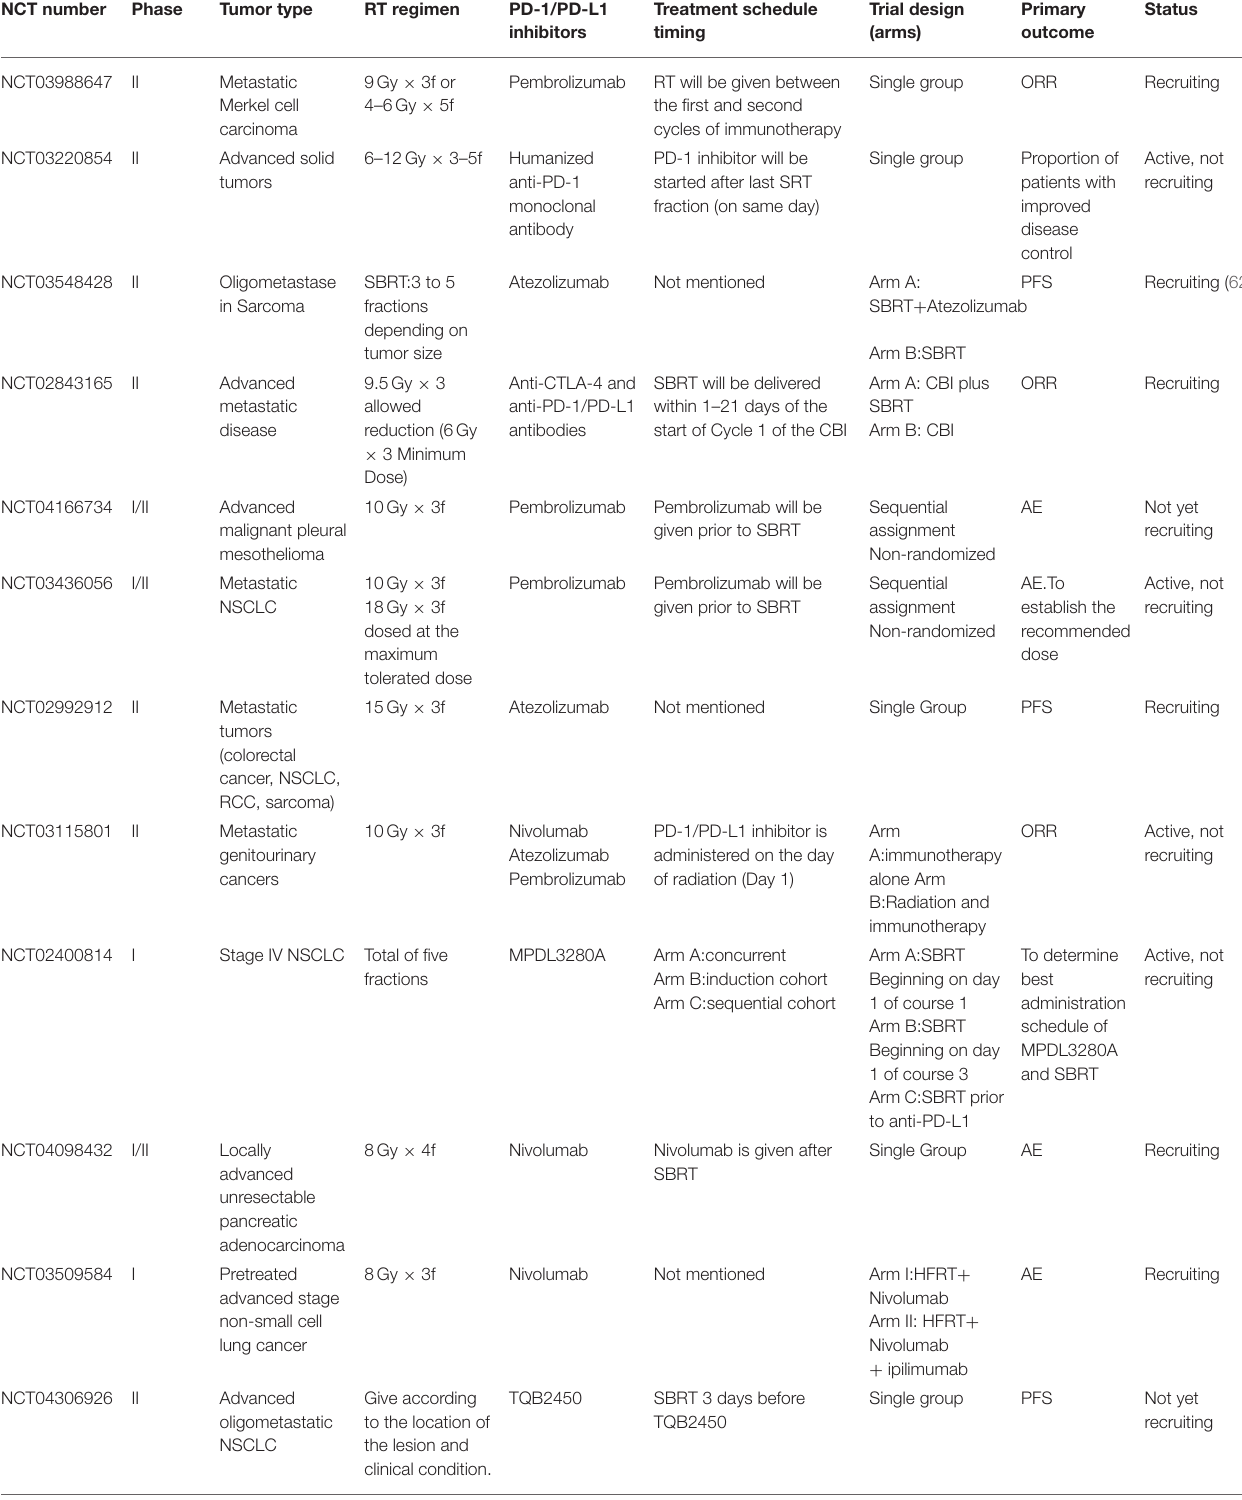
TABLE 1 | Trials testing radiotherapy in combination with PD-1/PD-L1 in advanced metastatic cancers that allowed only one irradiated lesion or did not mention the irradiated numbers. NCT